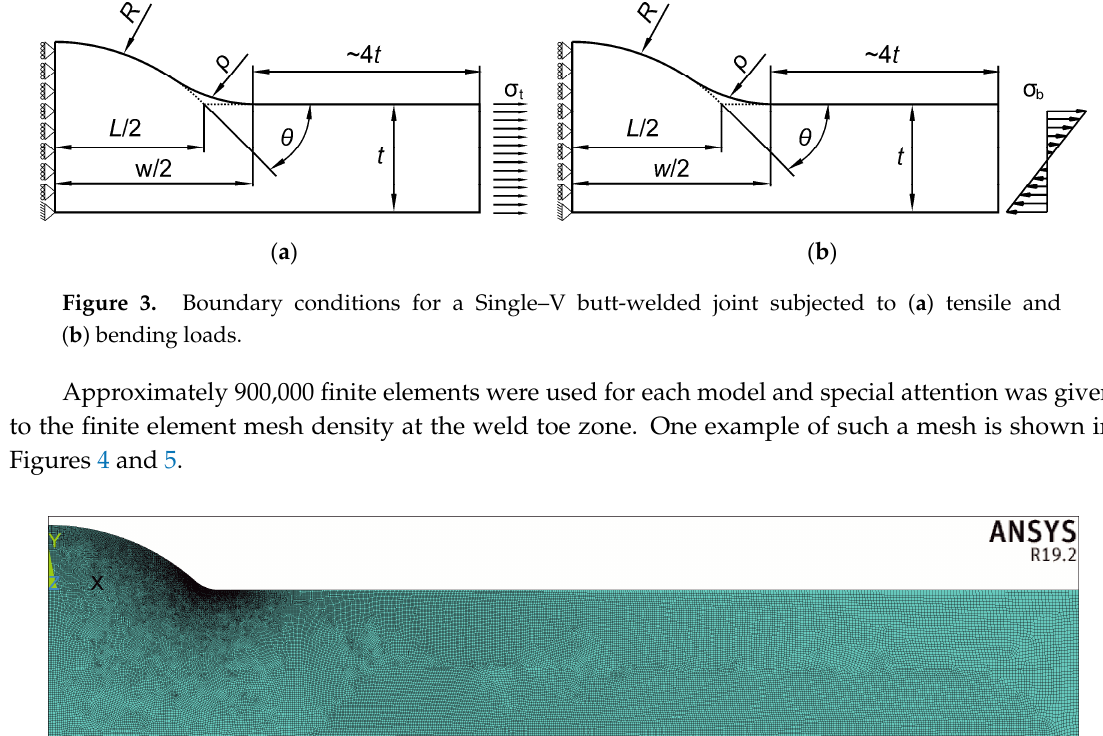
Figure 4. Example of a finite element mesh for X = 0.1, Y = 2/3 and θ = π /4.